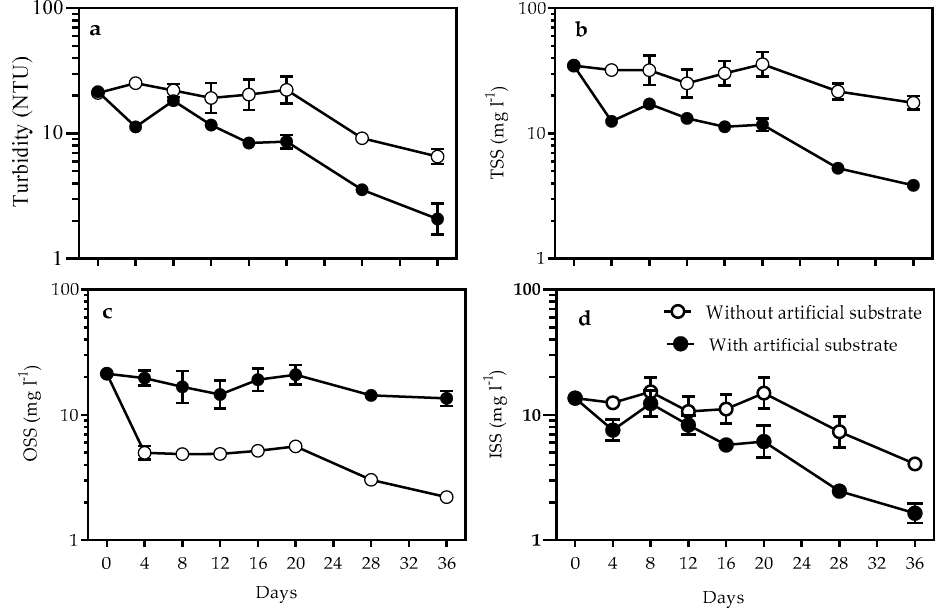
Figure 3. Comparisons of ( a ) turbidity; ( b ) total suspended solids (TSS); ( c ) organic suspended solids (OSS); and ( d ) inorganic suspended solids (ISS) concentrations between treatments with and without artificial substrate during the experiment.